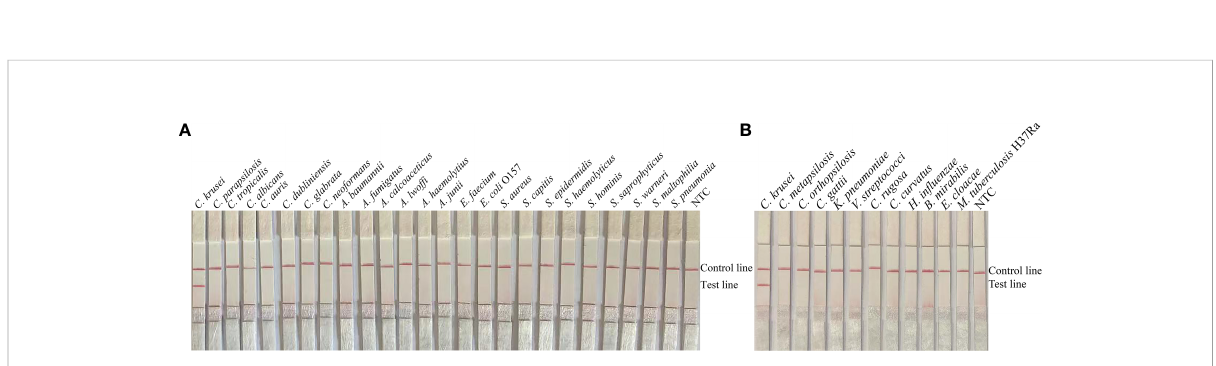
FIGURE 4 Speci fi city of F5/P/R2B. C. krusei ATCC 14243 was used as a positive control for other pathogenic bacteria tested. (A, B) Species names are indicated at the top of each strip. NTC indicates the no-template control specimen. The positions of the test and control lines are indicated on the right side of the image. Reactions were performed at 37°C for 20 min. The image is representative of the results of three independent experiments.